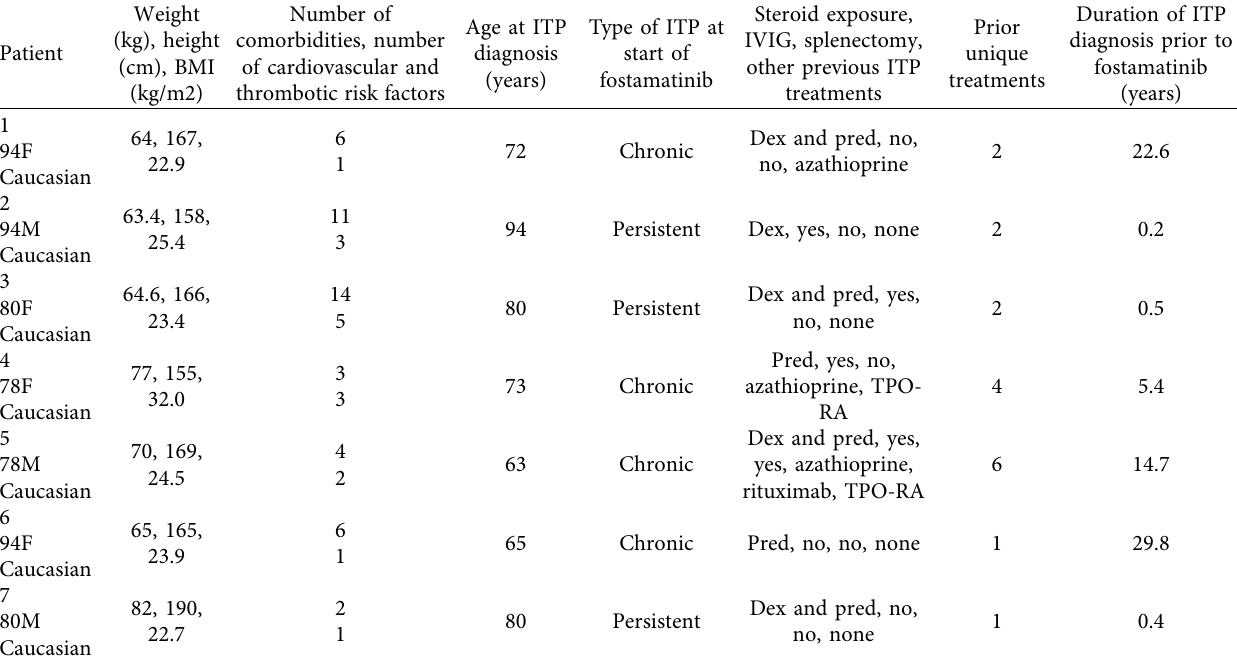
Table 1: Baseline